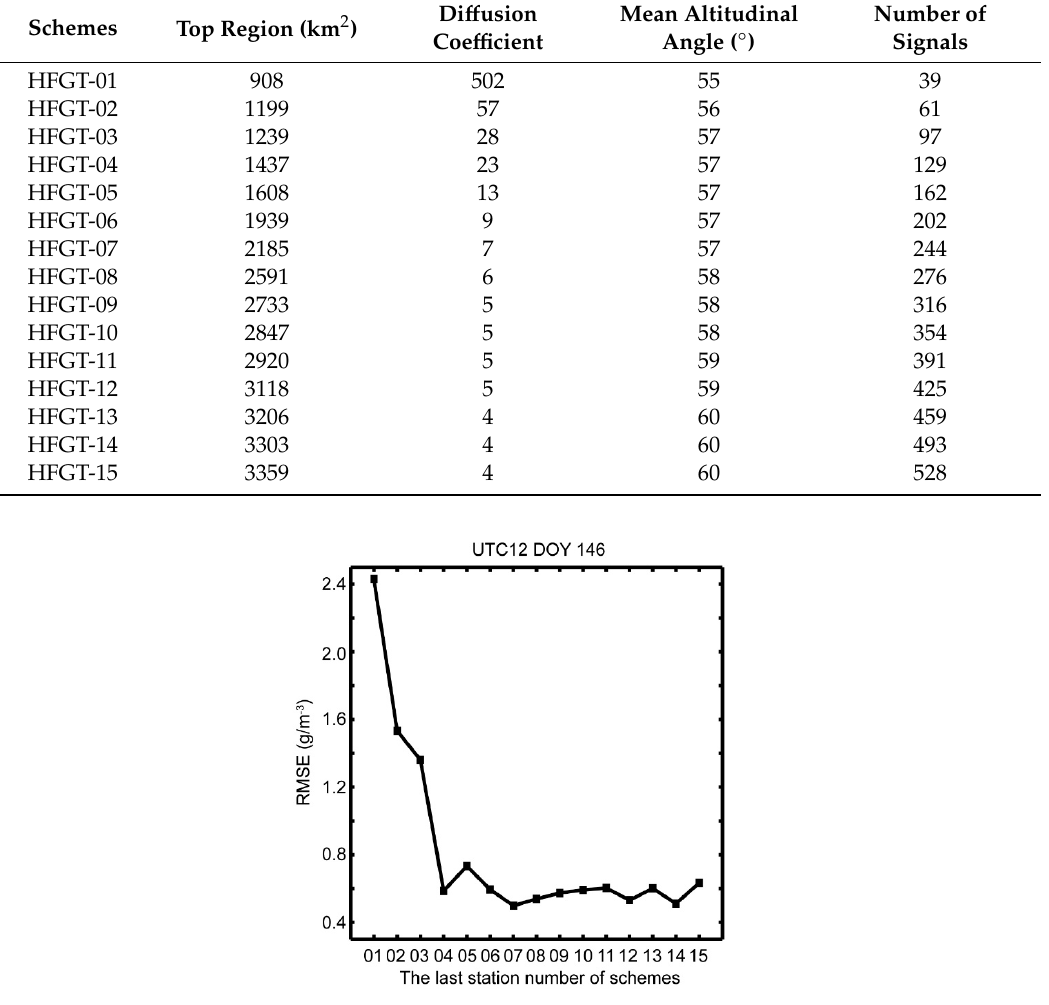
Table 2. Mean monthly of the GNSS tomographic region-related parameters.